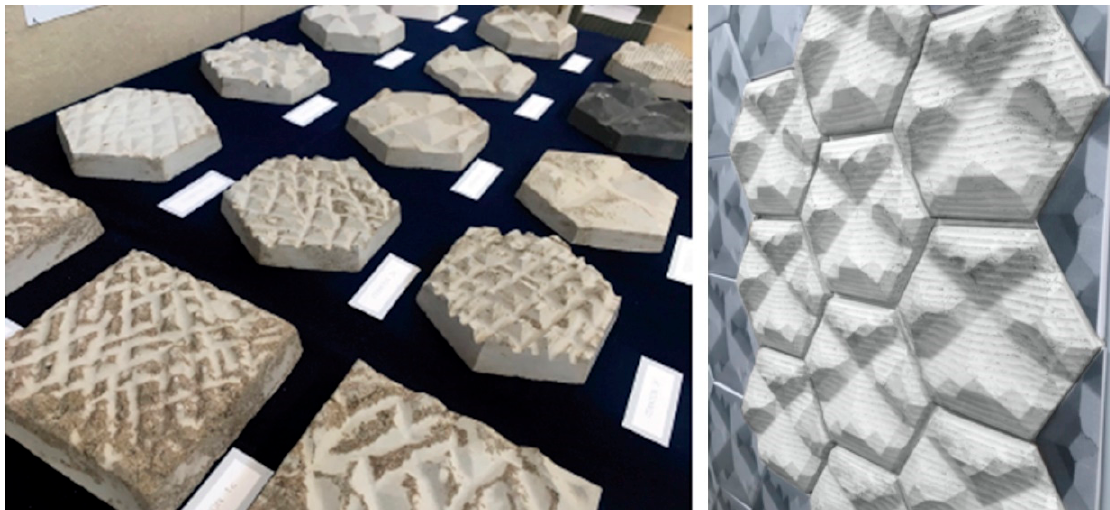
Figure 16. Left: Photograph of the cumulative textures of the various investigations, and right: The assembly of a potential application using P1 prototype.